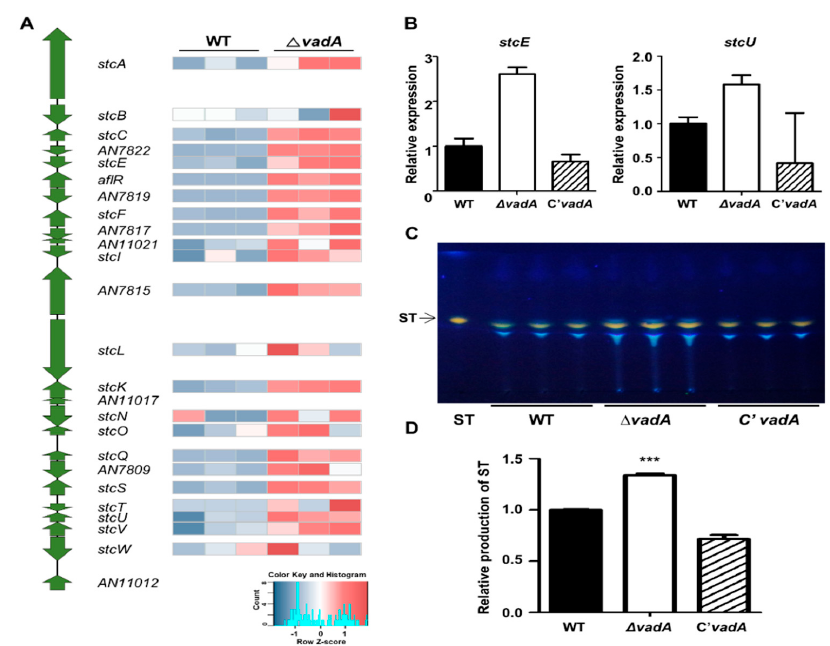
Figure 5. The role of VadA in sterigmatocystin production in conidia. ( A ) Heat map diagram of genes in sterigmatocystin gene clusters. ( B ) mRNA expression of stcE and stcU in control (THS30), Δ vadA (THS33), and C’ vadA (THS34) conidia were assessed by qRT-PCR. ( C ) TLC image of sterigmatocystin from control (THS30), Δ vadA (THS33), and C’ vadA (THS34) conidia. ( D ) Relative production of sterigmatocystin shown in (C). Error bars represent standard deviation (differences between the vadA mutants and control strains. *** p < 0.001).